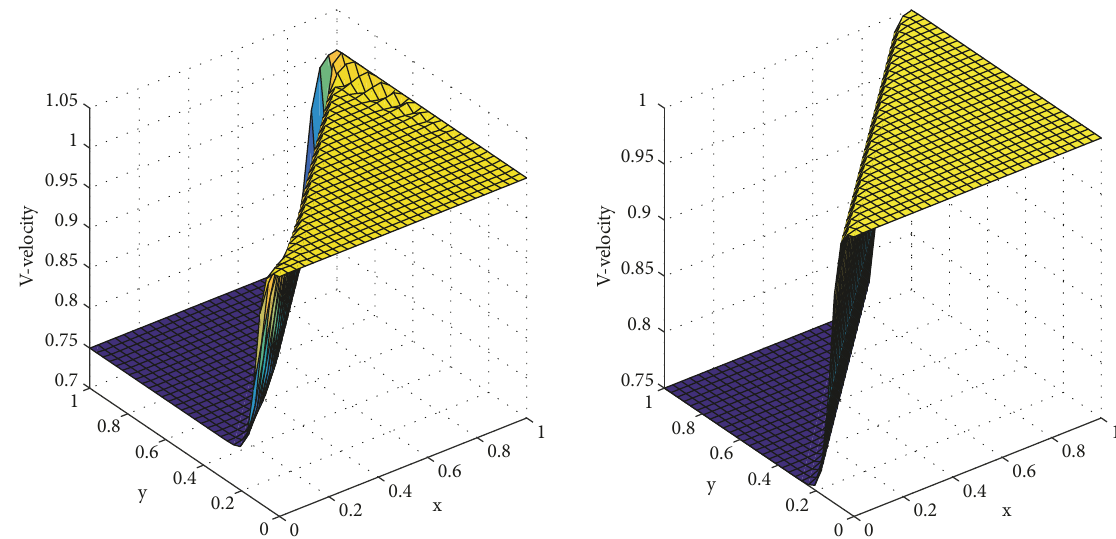
Figure 6: V-velocity profile Average produced by (left) the Hermite collocation scheme and (right) The exact, at Re = 500 with 𝑡 = 0.5,Δ𝑡 = 0.001 , and 𝑁 = 30 × 30